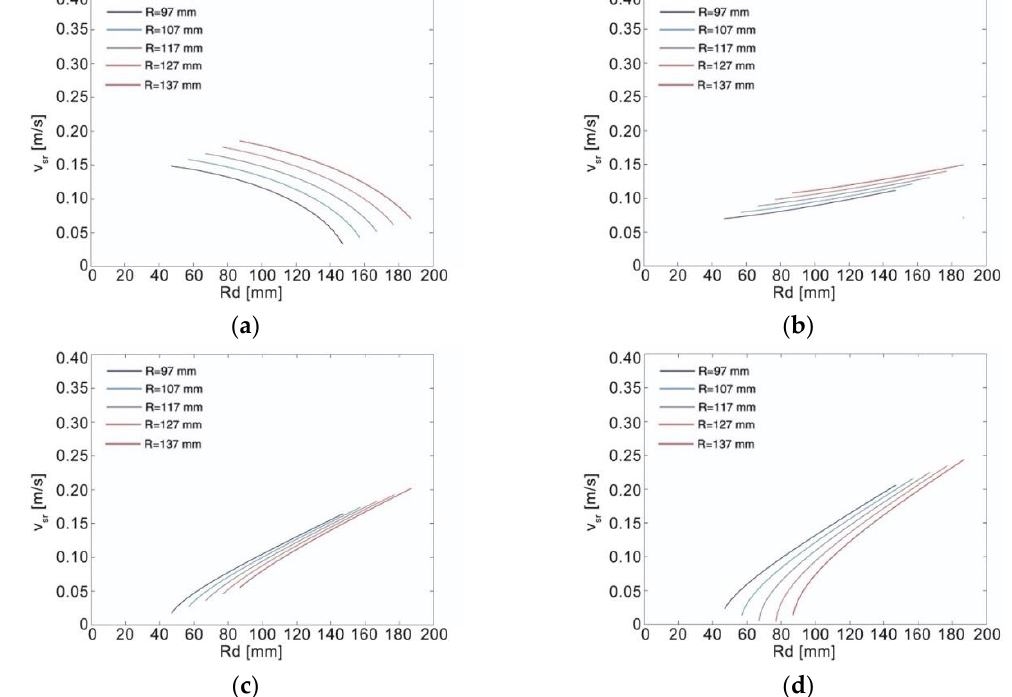
Figure 5. Average velocity distribution v sr as a function of radius R d for different parameters k 1 : ( a ) k 1 = − 20 / 9; ( b ) k 1 = − 5 / 9; ( c ) k 1 = 5 / 9; and ( d ) k 1 = 13 /